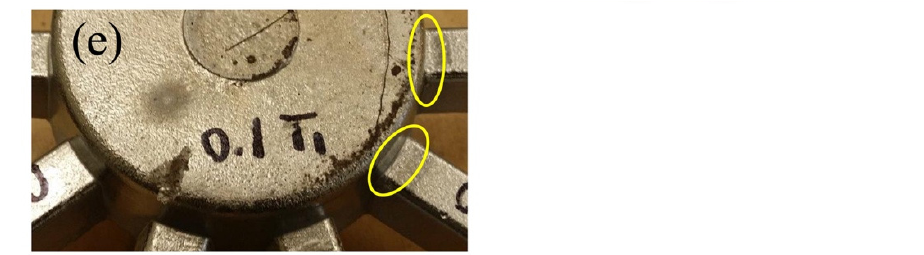
Figure 7. Pictures of representative multi-arm castings with 0.1 wt.% Ti addition: ( a ) DA1, ( b ) DA2, ( c ) DA5, ( d ) DA6, and ( e ) DA7.